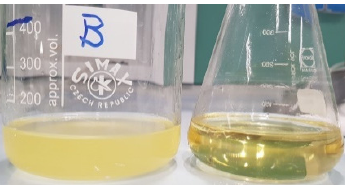
Figure 7. A sample of crude biodiesel ( left ) and purified biodiesel after methanol vacuum distillation ( right ).